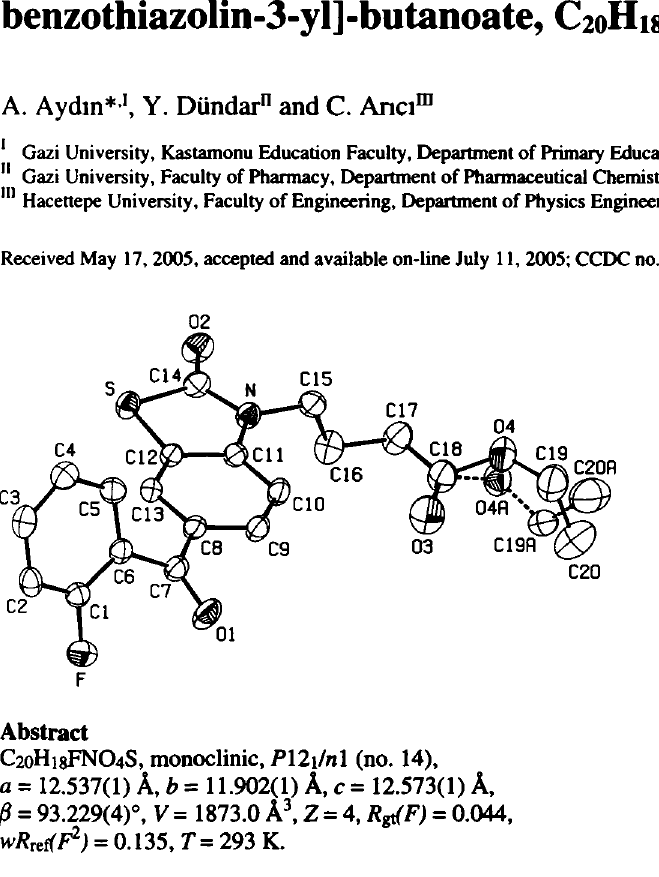
Table 1. Data collection and handling.